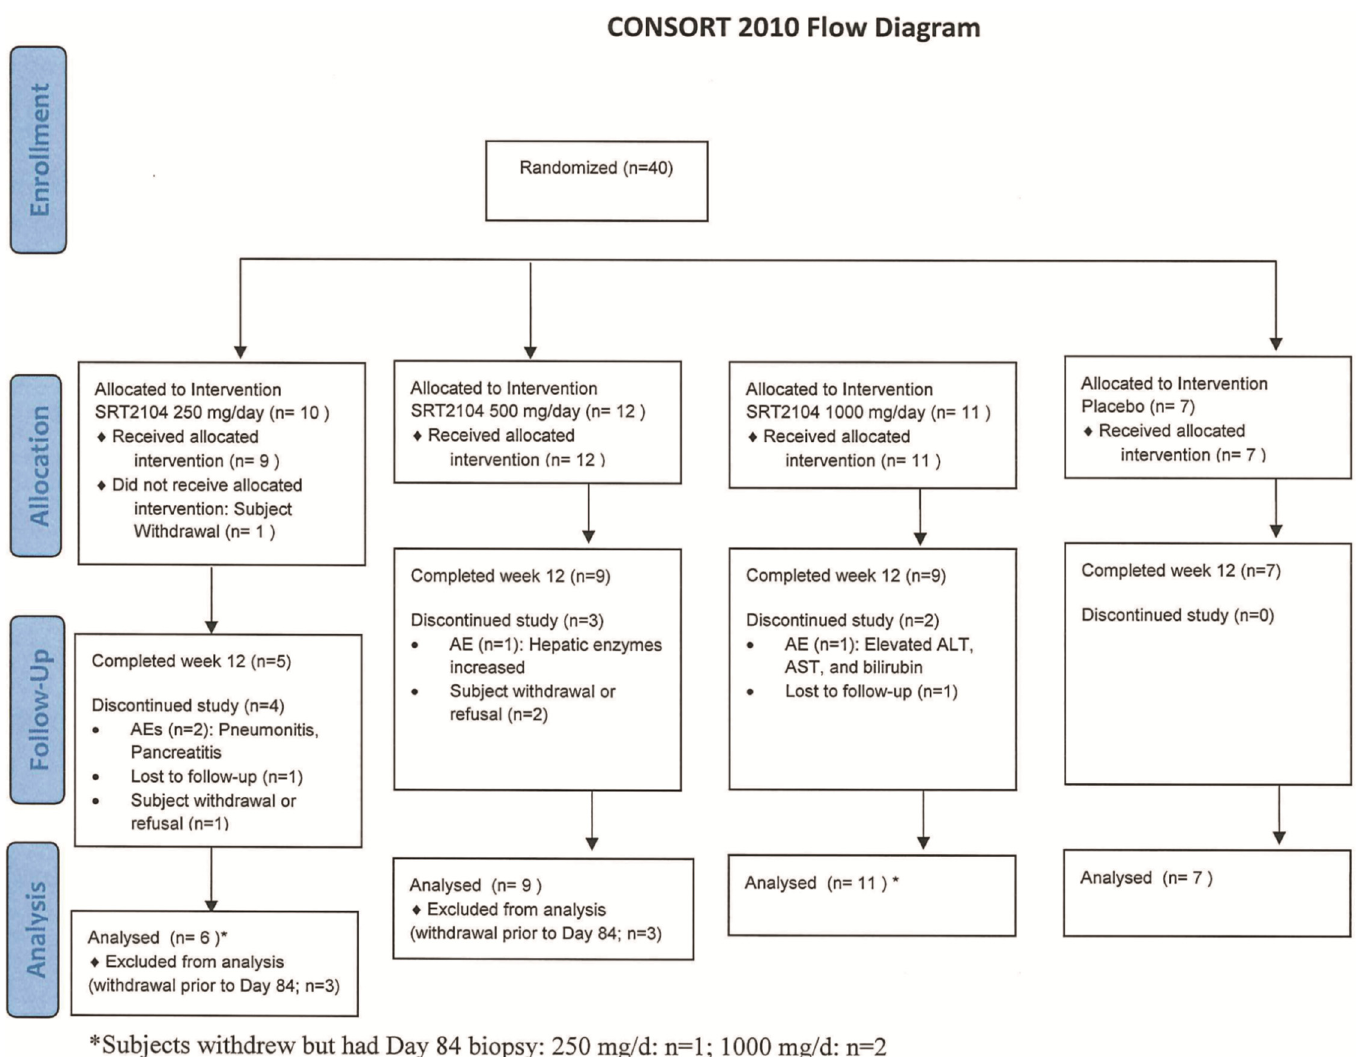
Fig 1. CONSORT 2010 Flow Diagram. The scheme graphically outlines the design and conduct of the clinical study.